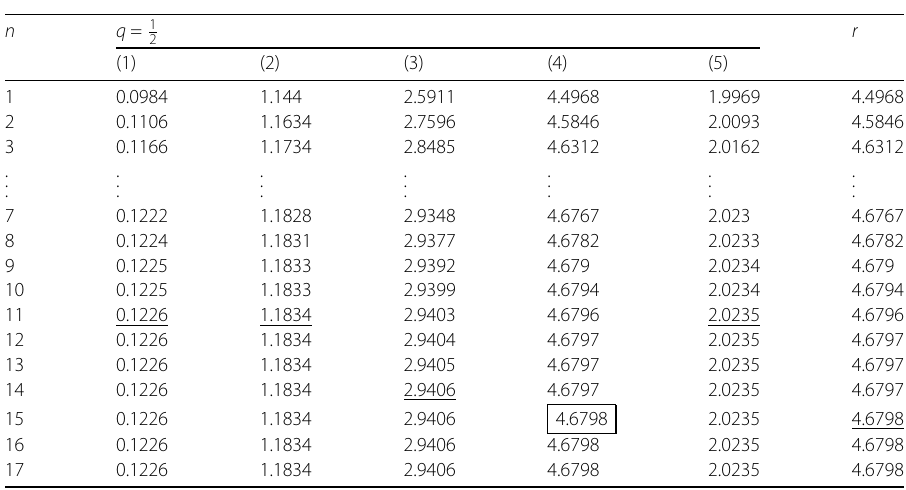
Table 11 Numerical results of (1) = L 1 Λ 1 + | 1 b 0 | and ( i ) = L i Λ i + 2 for q = 1 10